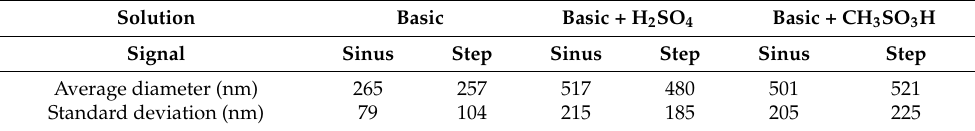
Table 3. The average diameter of PA 6 nanofibers based on the solvent system and their standard de-